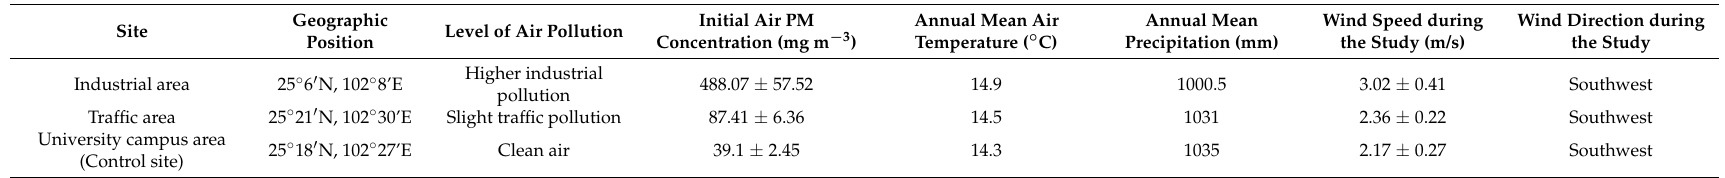
Table 2. Environmental conditions across the three functional zones (industrial, traffic and university campus) in Kunming City, Southwest China.